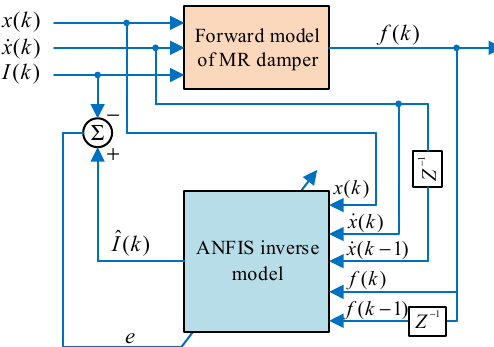
Figure 8. Schematic diagram of the ANFIS inverse dynamics model. Two sets of data were needed to model a MR damper, using an adaptive neuro-fuzzy reasoning system. One set was used to train the inverse model of ANFIS, and the other set was used to test the accuracy of the model. A sinusoidal function with an amplitude of 20 mm was used for the displacement signal, and a sinusoidal function with an ampli- tude of 0~2 A was used for the control current signals. There were 1500 data points of which 1000 points were used for training and 500 points were used for validation.